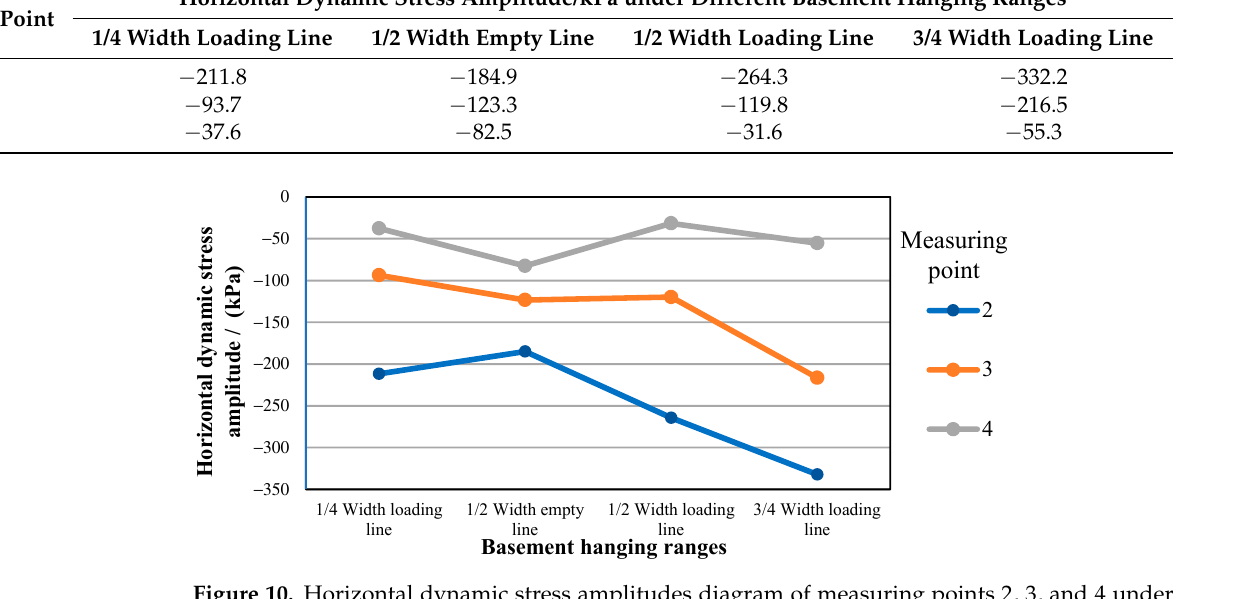
Table 11. Horizontal dynamic stress amplitudes of measuring points 2, 3, and 4 under different basement hanging ranges. Measuring Point